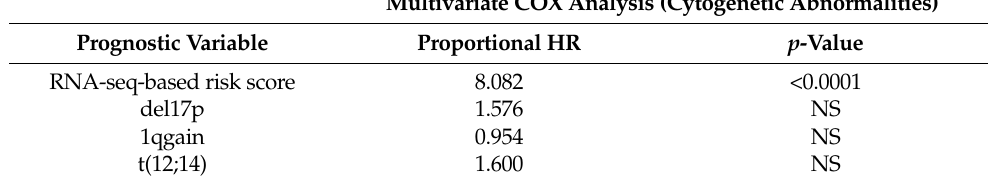
Table 2. Cox univariate and mutations.